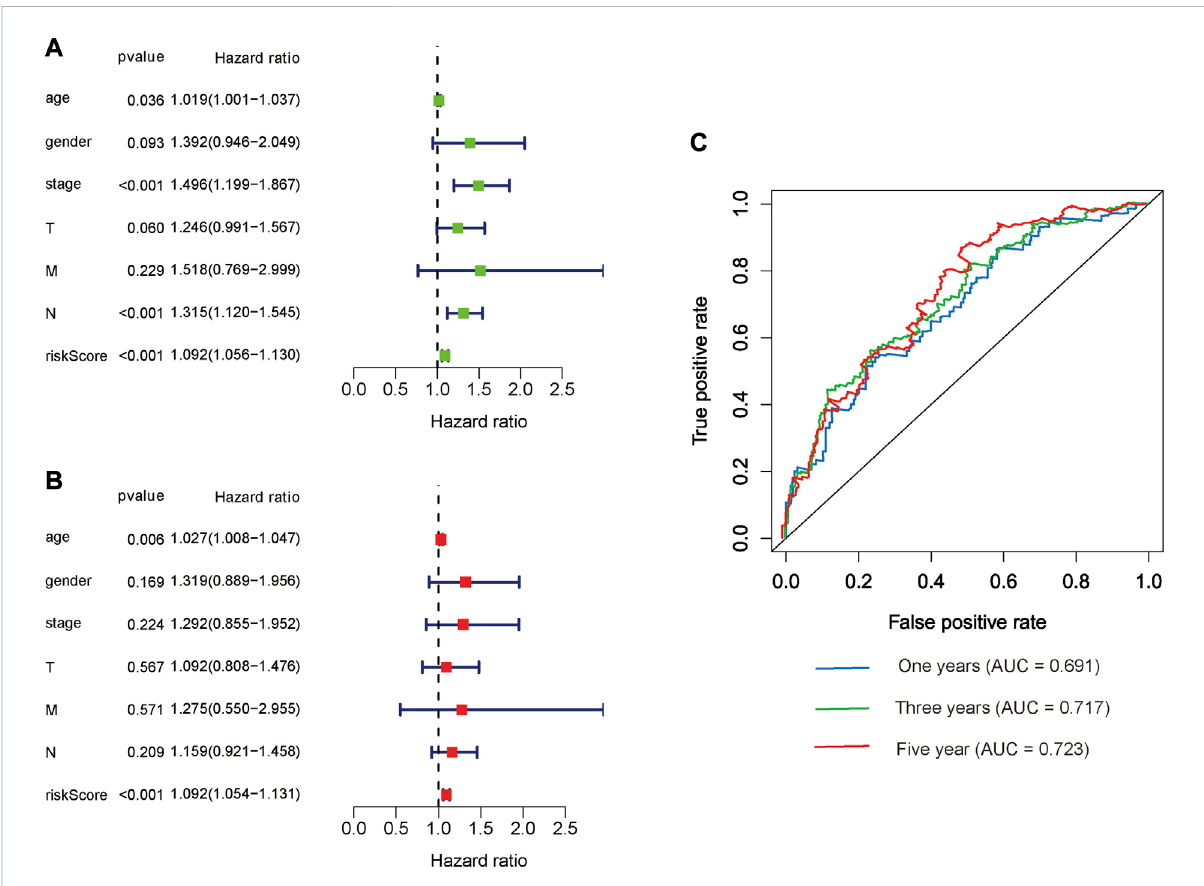
FIGURE 6 Prognostic indicators based on glycolysis-related lncRNAs showed great predictive performance. The forest plots for univariate (A) and multivariate (B) Cox regression analysis in STAD. (C) The areas under the ROC curve about 1-year, 3-year, and 5-year OS.